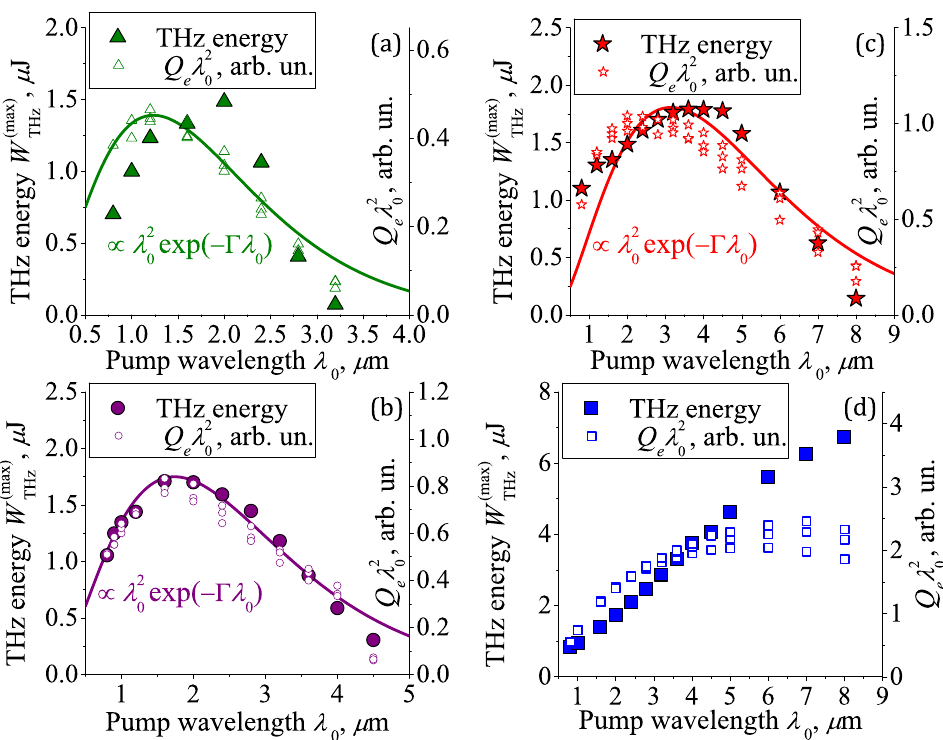
Figure 3. Dependence of the maximal energy of generated THz radiation W (max) simulations on the pump wavelength λ 0 (filled markers) in comparison with Q e λ 2 markers) for four focal distances: ( a , green) 25 cm, ( b , violet) 15 cm, ( c , red) 10 cm, and ( d , blue) 5 cm. Solid colored curves show the fits